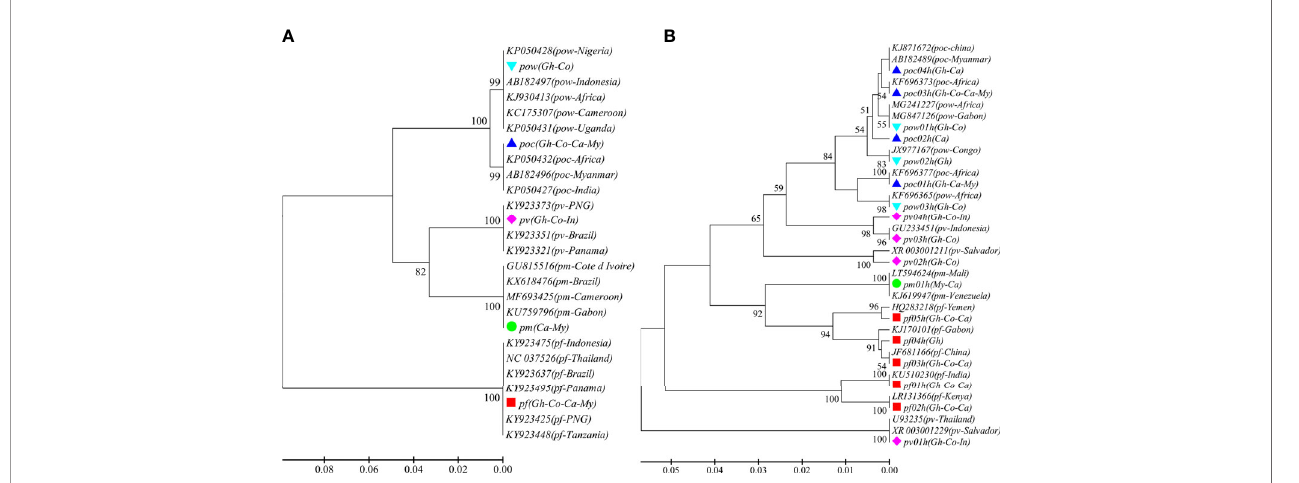
FIGURE 1 | The phylogenetic UPGMA tree of haplotypes determined by amplicon deep sequencing. (A) CYTB phylogenetic tree for the 5 species and 21 sequences retrieved from GenBank (KY923637, KY923475, KY923495, KY923425, KY923448, NC_037526, KX618476, MF693425, GU815516, KU759796, KP050432, KP050427, AB182496, FJ409565, KJ930413, AB182497, KP050428, KP050431, KY923351, KY923321, KY923373). (B) SSU phylogenetic tree for the haplotypes of the 5 species and 19 sequences retrieved from GenBank (GU233451, JF681166, KJ170101, KJ619947, KU510230, MG241227, MG847126, U93235, XR_003001229, XR_003001211, LR131366, LT594624, KJ871672, AB182489, KF696373, KF696377, JX977167, KF696365, HQ283218). pf , Plasmodium falciparum ; pv , P. vivax ; pm , P. malariae ; poc , P. ovale curtisi ; and pow , P. ovale wallikeri. Different color markers represent different species identi fi ed in this study. Gh , Ghana; Co , Congo; Ca , Cameroon; My , Myanmar; and In ,